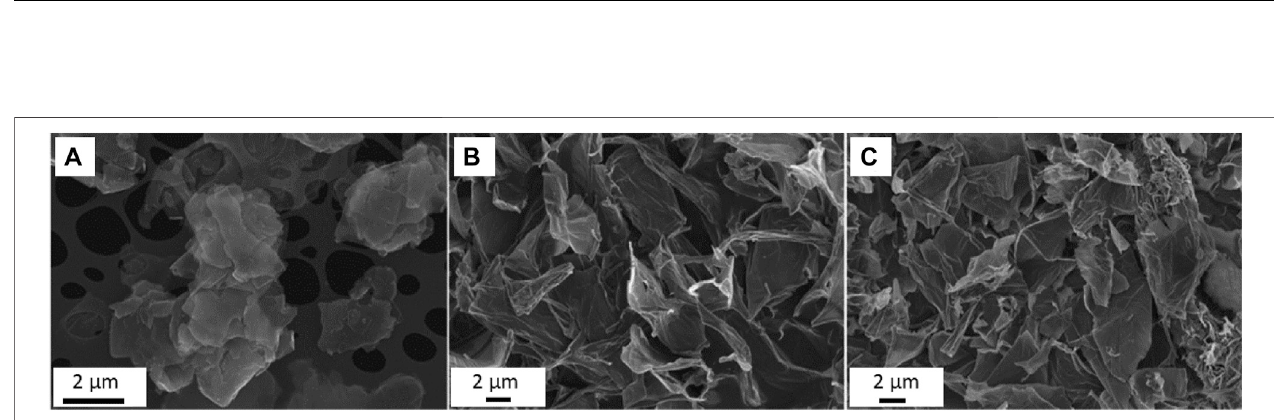
FIGURE 3 | Comparison of morphologies of graphene fl akes (A) , GO (B) and RGO (C) using SEM analysis (Reproduced with permission from (Jastrze¸bska et al., 2017a)).